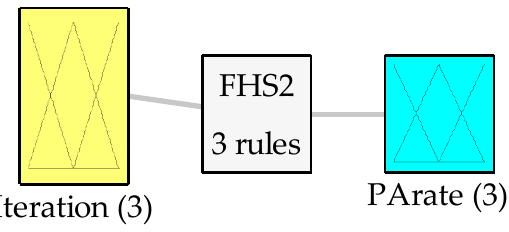
Figure 6. Fuzzy System for Increasing PArate.